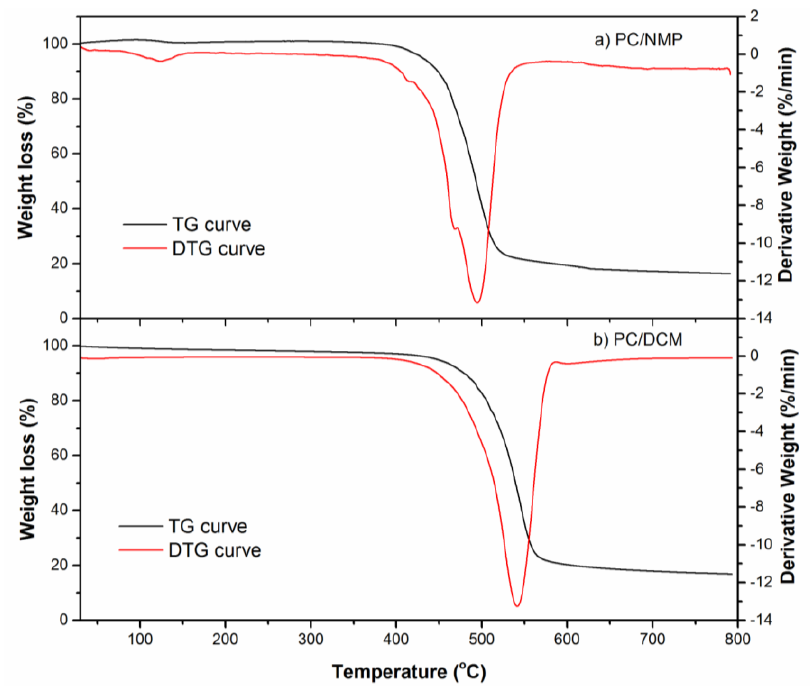
Figure 9. TGA and DTG curves for PC membranes prepared by ( a ) 18 wt % PC/NMP and ( b ) 18 wt % PC/DCM.